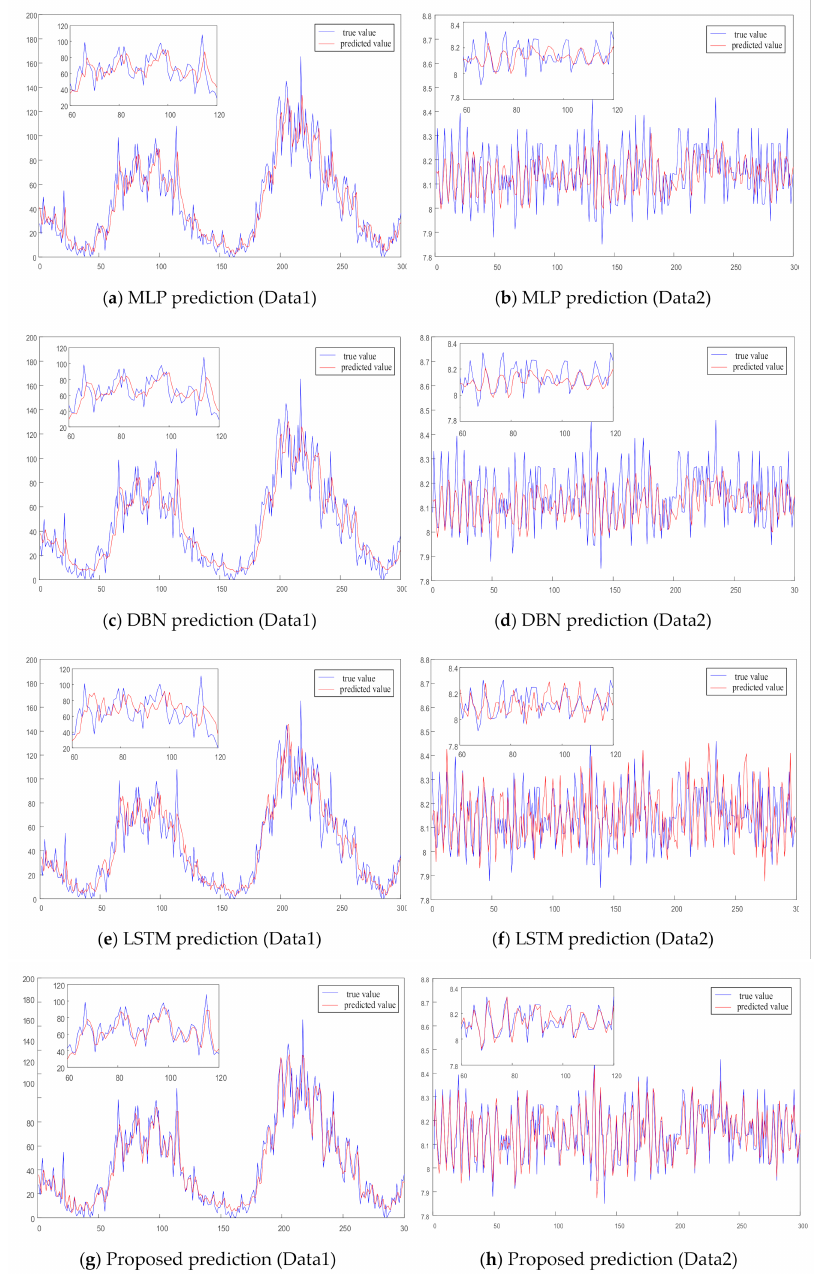
Figure 9. Single-step prediction results. Due to the randomness of neural network in the training process, the results of each training were different. In order to ensure the validity of the experimental results, all neural network models were trained for 10 times and the average value was taken. The prediction results of each method are shown in Table